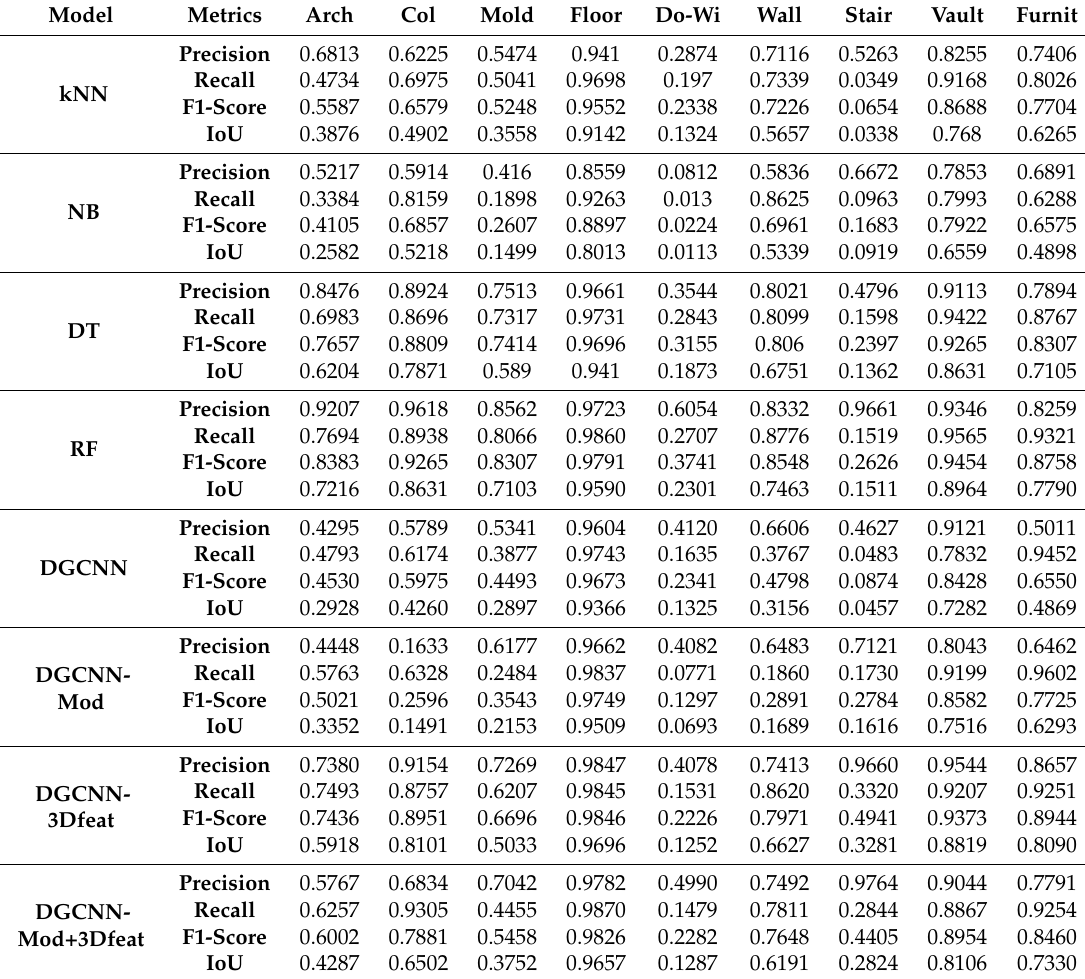
Table A1. The Trompone scene has been divided into 3 parts: training, validation and test. In this Table we can see the metrics for every class, calculated on the test